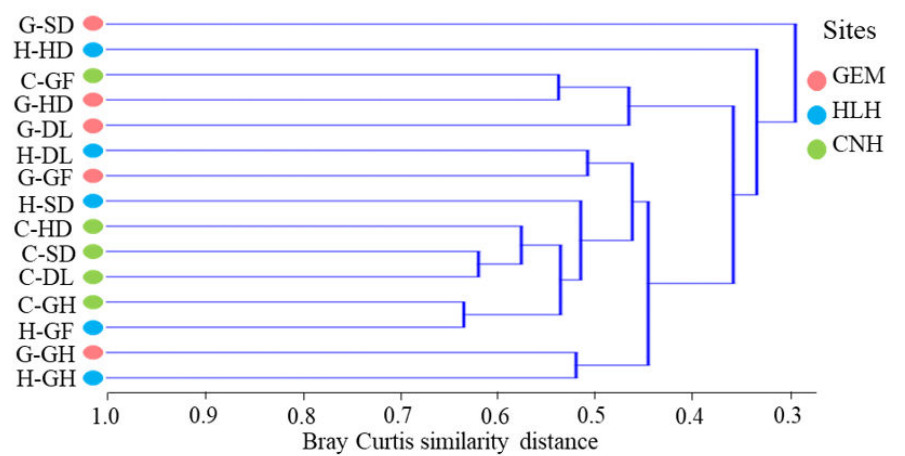
Figure 3. A Bray Curtis distance tree (at a ≥ 97% sequence similarity level) of the bacterial population of the cold-desert, Qinghai–Tibet Plateau, China: The tree was generated using Algorithm PAST software with the statistical computing paired group (UPGMA). The distance for each pair of samples (habitat) is showed by the position of the node between them, according to the Bray Curtis similarity indices. More details are shown in Table S3. CNH—CuoNaHu, HLH—HongLiangHe, GEM—GeErMu.